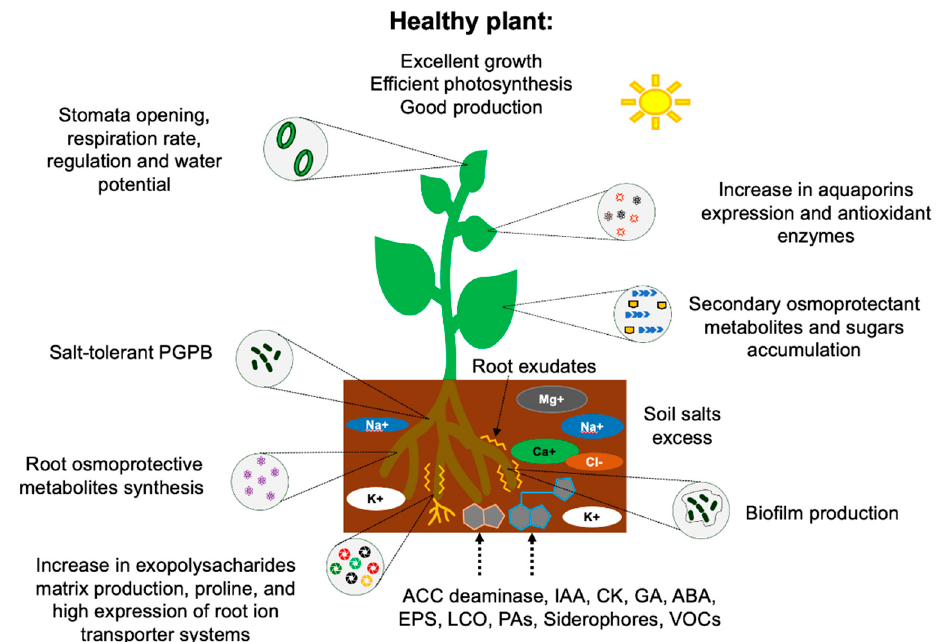
Figure 2. Salt tolerance mechanisms promoted by plant growth-promoting bacteria (PGPB). After that, PGPB colonize the surface of plant roots growing in saline soil, and a plant–bacteria communication is established through the synthesis of chemical signals that improve the plants’ physiology, growth, and reproduction. ACC deaminase: 1-aminociclopropane-1-carboxylase deaminase enzyme. IAA: Indole acetic acid. CK: Cytokinins. GA: Gibberellins. ABA: Abscisic acid. EPS: Exopolysaccharides. LCO: Lipo-chitooligosaccharides. PAs: Polyamines. VOCs: Volatile organic compounds. Table 1. Plant growth-promoting bacteria (PGPB) and their mechanisms targeted at helping plants to deal with salinity stress. PGPB Species Mechanisms Reference